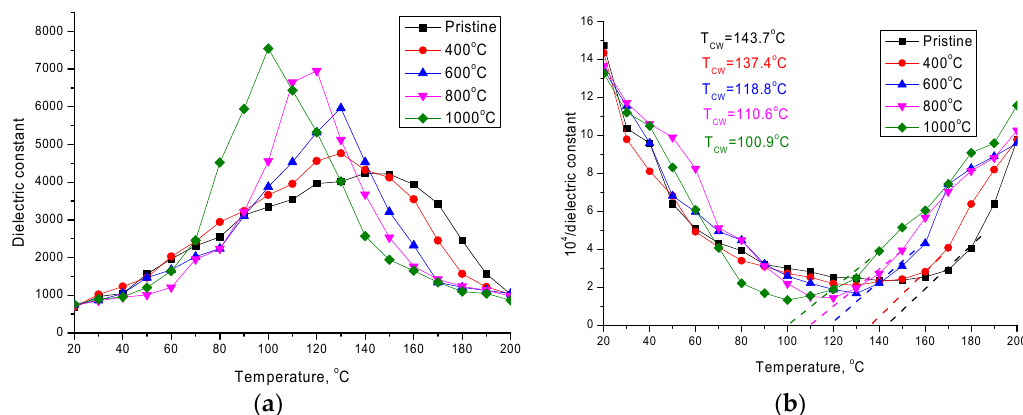
Figure 6. ( a ) Graph of changes in the dielectric constant; ( b ) graph of inverse dielectric constant and Curie–Weiss temperature.